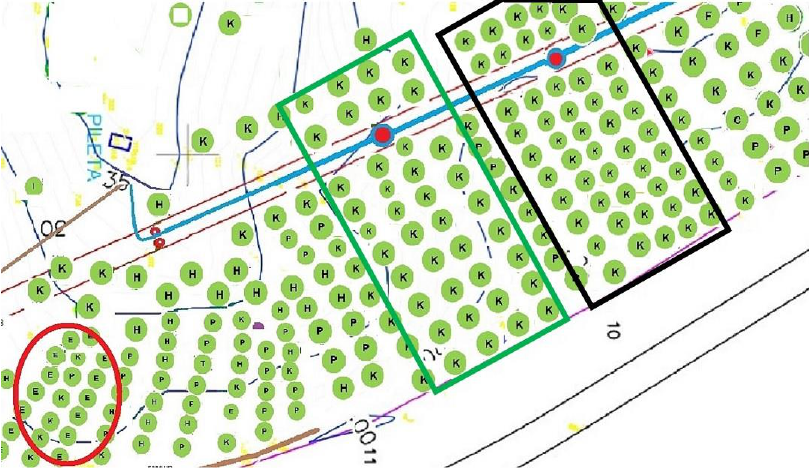
Figure 1. Orchard showing high-density trees (red circle), 25-year-old trees (green square) and 35-year-old trees (black square). Kent tree: K; recent planted: P; Haden tree: H; Keitt tree: E. Trees were grown in a basaltic clay loam red soil, having an average density of 1.1 gcm −3 [37]. The top layer of 3 cm around the trees was covered by organic soil obtained from composting organic matter, falling leaves and branches. After harvest, before prun- ing takes place, NPK fertilizer (250 g N, 70 g P 2 O 5 and 210 g K 2 O) were applied to each tree. Three kilograms of granular fertilizer was manually applied to each mature tree within a circular groove, 250 cm around the tree trunk. The 5 cm wide groove was 5 cm deep. High-density trees planted had 800 cm between each row and 400 cm in-row spac- ing giving a total of 315 trees ha −1 . One kilogram of the same granular fertilizer was ap- plied to high-density trees. The fertilizer was evenly applied within a circular groove with a radius of 1.5 m centered at the tree trunk.